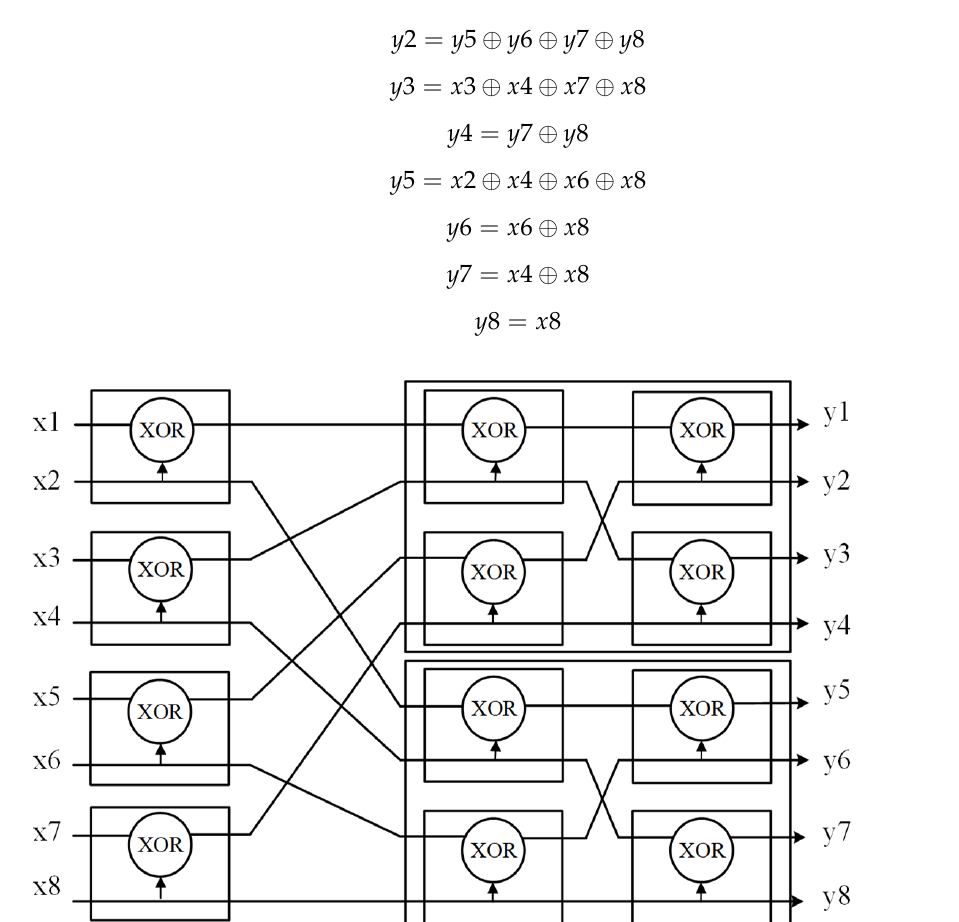
Figure 20. Schematic diagram of a polar encoder [27].